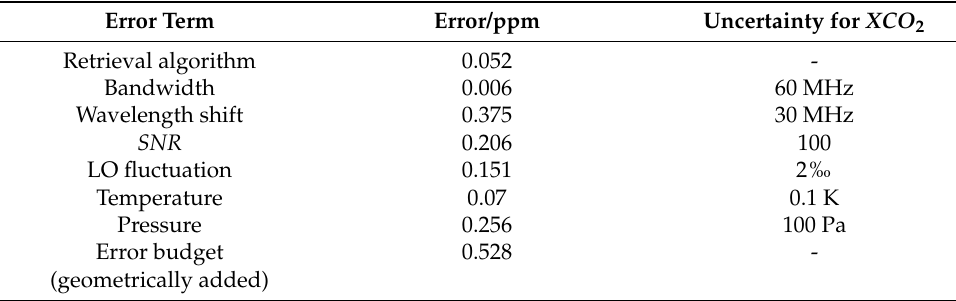
Table 6. Contributions of various error terms of LHR